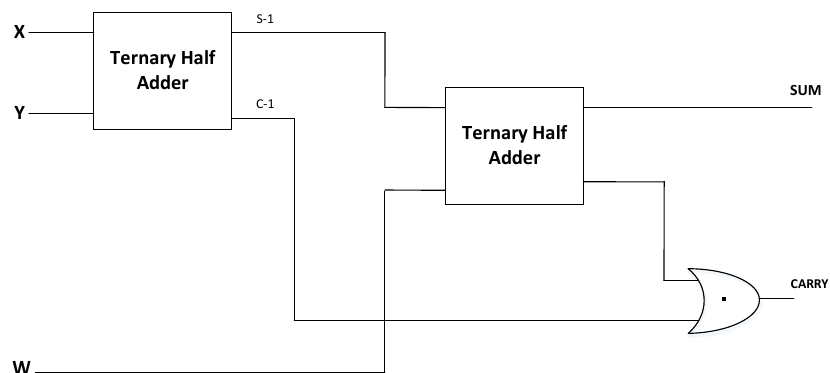
Figure 9. Block diagram of CNTFET-RRAM ternary full adder.